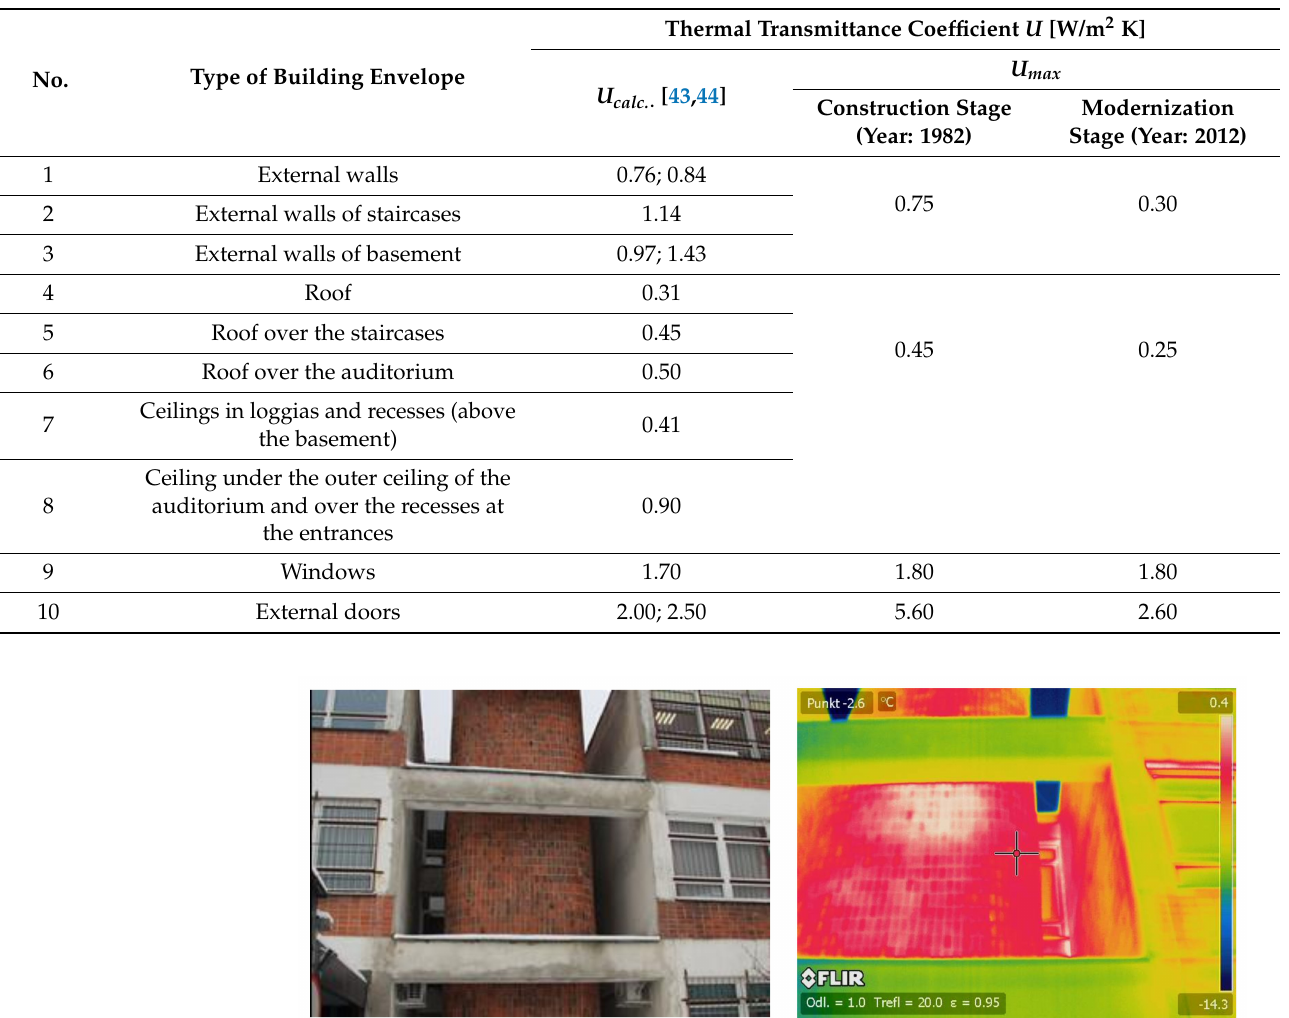
Figure 3. View of the staircase, to be insulated and a thermal image [photo authors].